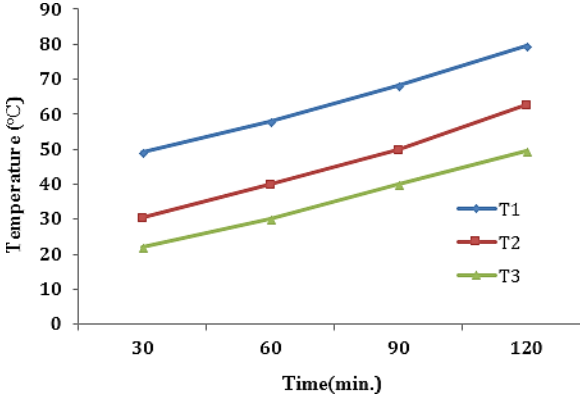
Figure 5: The temperature distribution of (TiN/Al 2 O 3 /TiCN) speci- men at a constant source temperature of 100 ∘ C